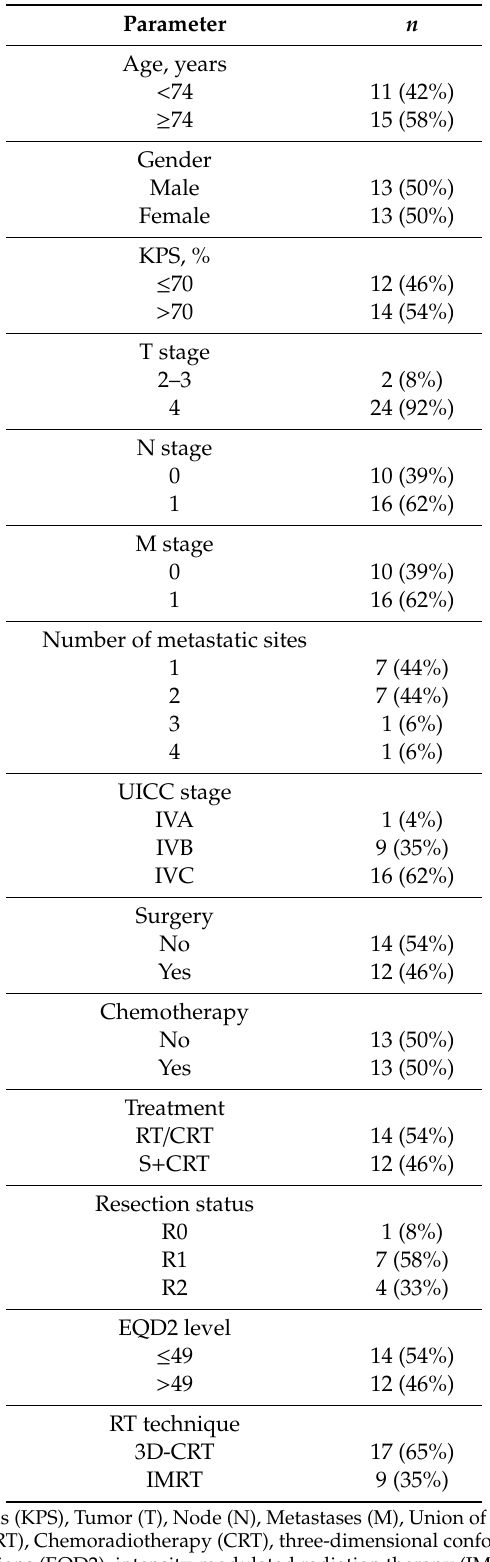
Table 5. Patient- and treatment-related